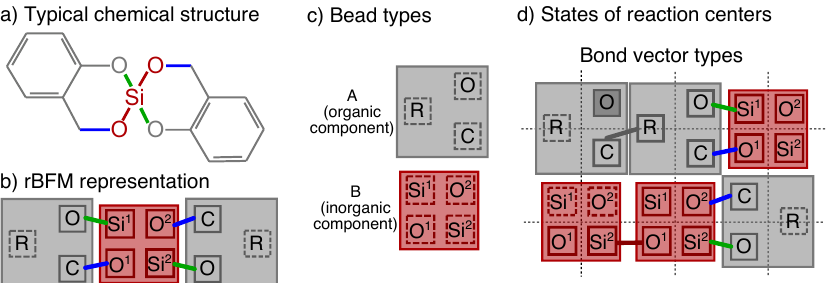
Figure 1. The chemical structure of the typical twin monomer 2,2 (cid:48) -spiro[4 H -1,3,2-benzodioxasiline] is shown in ( a ), and its reactive bond fluctuation (rBFM) representation in 2D in ( b ). It is represented by two bead types (A,B) and five different reaction centers (O,C,R,O x ,Si x , with x = { 1,2 } ) as illustrated in ( c , d ). In ( d ) all possible states of the reaction centers and all possible bond vector types are given in an exemplary 2D-cutout of the cubic lattice. A corresponding 3D representation is given in Figure 2. Reaction centers with a solid square are bonded, with a dashed square are non-bonded and with darker filling are blocked. Note that to make it easier to differentiate between the reaction centers that are all placed in the center of the beads, here they are plotted next to each other.